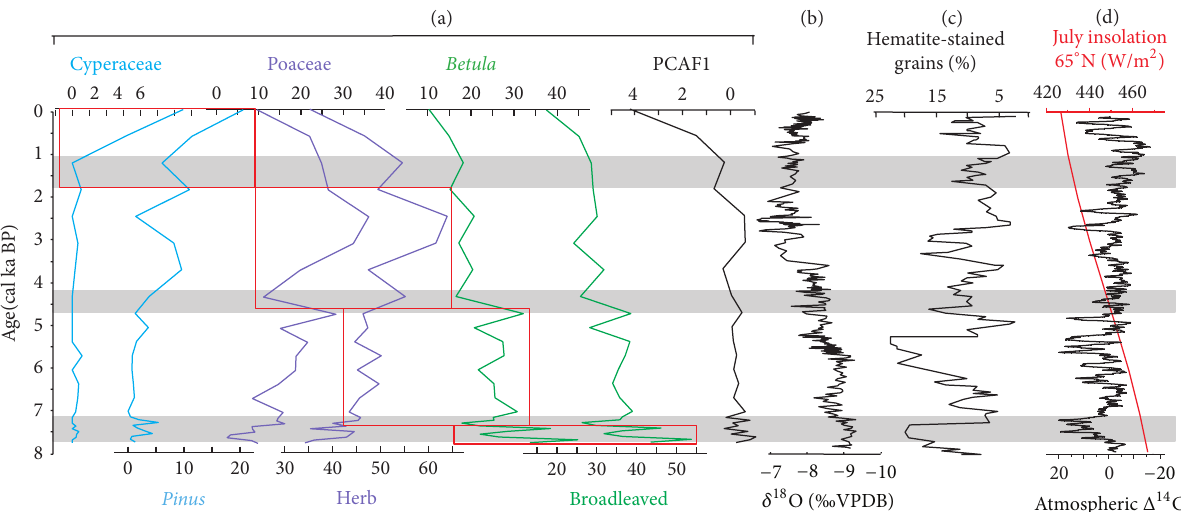
Figure 6: Comparison of principal pollen percentages and the PCA F1 curve from the Beihong Section with other selected proxy records. (a) Pollen index from the Beihong Section. From the right to left are the PCA F1 curve, the percentage curves of broadleaved trees, Betula , herb, Poaceae, Pinus , and Cyperaceae. (b) Dongge Cave D4 [33]. (c) Holocene drift ice record for the MC52-VM29-191 North Atlantic core [34]. (d) Northern Hemisphere July insolation at 65 ∘ N [35] and the residual atmospheric Δ 14 C record ( ∼ 2000-year moving average) [36]. The lateral gray bands trace the interconnection between climate cooling, drift ice, a weakened EASM, reduced insolation activity, and the principal pollen taxa changes in this study. The red boxes show the main indicator plants of vegetation type conversion.